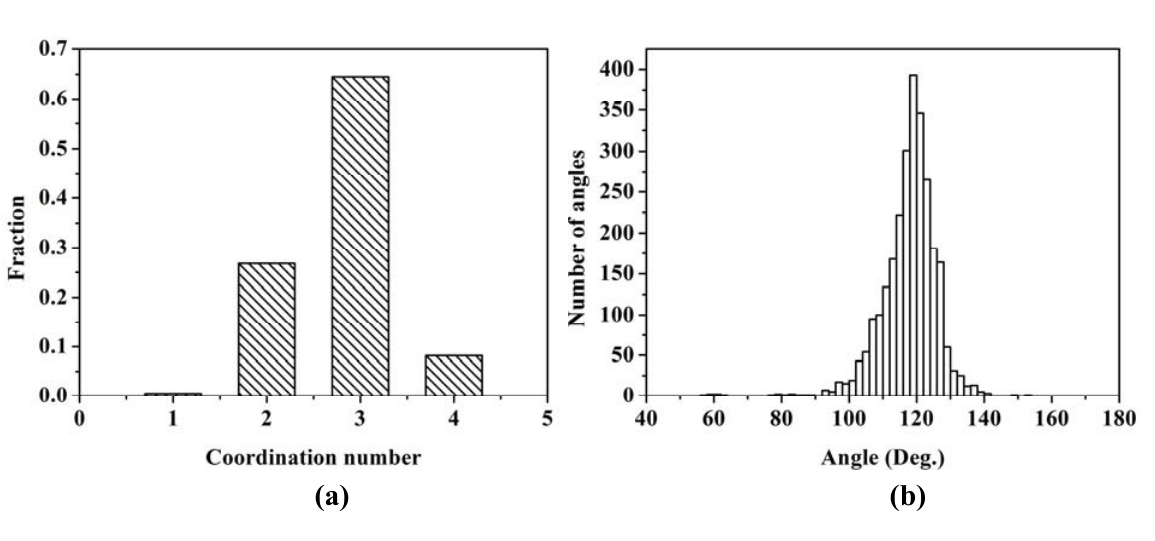
Figure 13. (a) Distribution of twofold, threefold and fourfold coordination numbers. (b) Distribution of bond angles. The first coordination layer is determined by the minimum between the first and the second peak of the RDF, 2.75 Å.